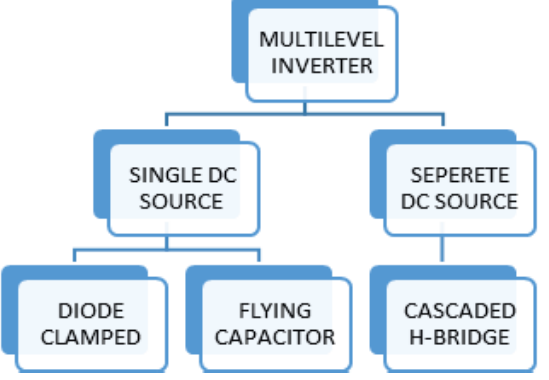
Figure 8. Current source inverter.